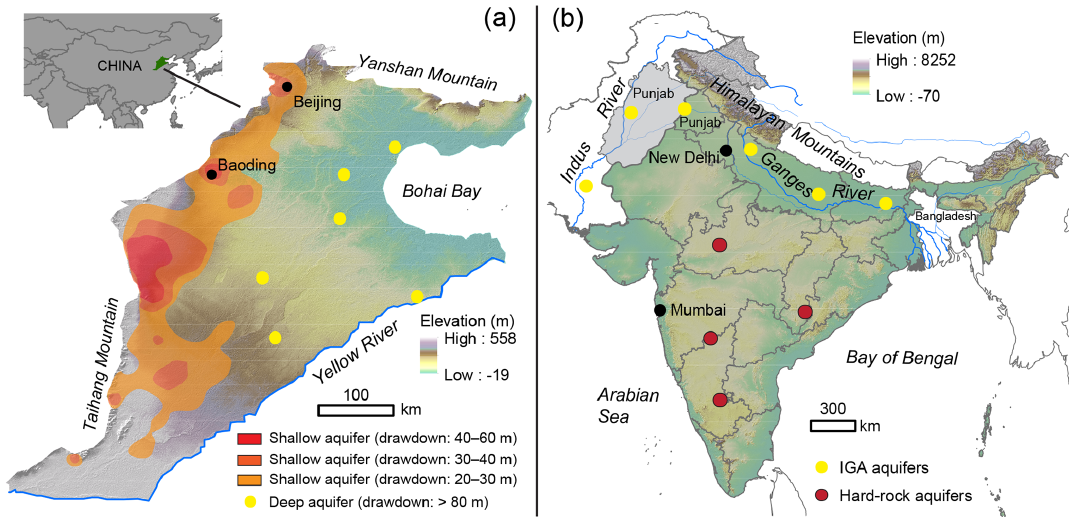
Figure 2. (a) is a shaded relief map of the core of the North China Plain. The red/orange colored areas have drawdowns > 20m in the shallow aquifer (Cao et al., 2012). The yellow dots indicate areas with local drawdowns in the deep aquifer > 80m (Zheng et al., 2012). (b) shows India, Pakistan, and Bangladesh. The red dots generally indicate the locations of hard-rock aquifers. The yellow dots point to the general location of the IGA system along the plains of the Indus and Ganges